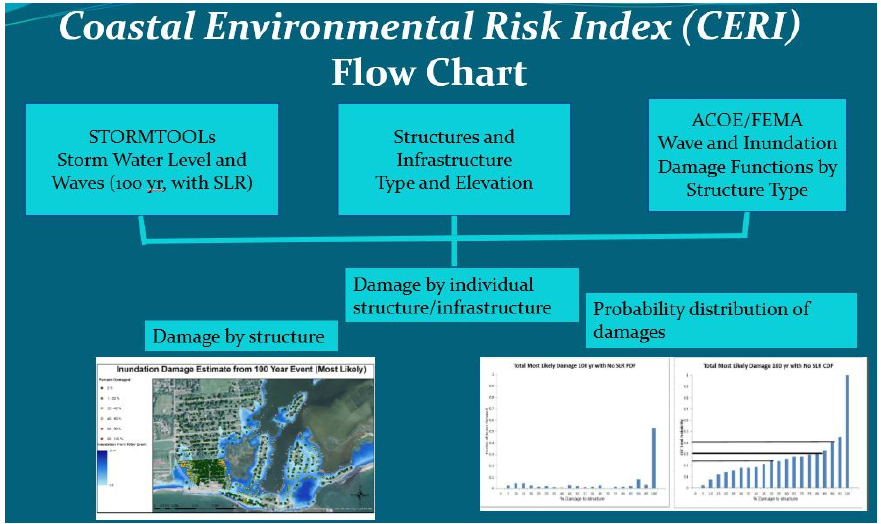
Figure 1. Flowchart of Coastal Environmental Risk Index (CERI) system